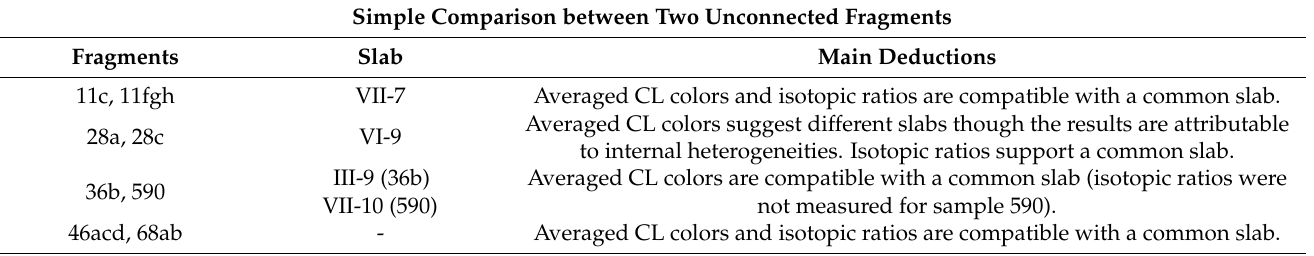
Table 7. Main deductions from the checked reconstruction